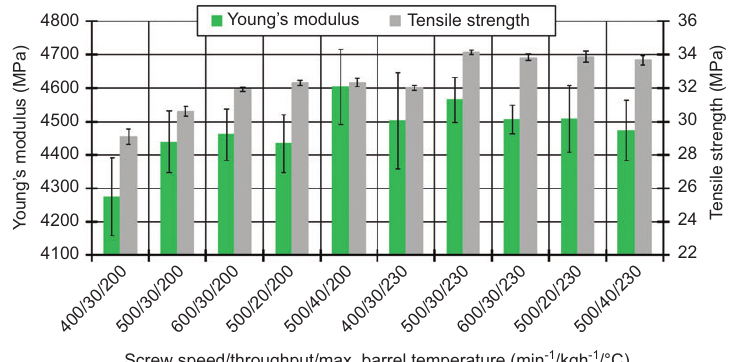
Figure 3 Young ’ s modulus and tensile strength for different process parameters at maximum barrel temperatures of 200 ° C and 230 °